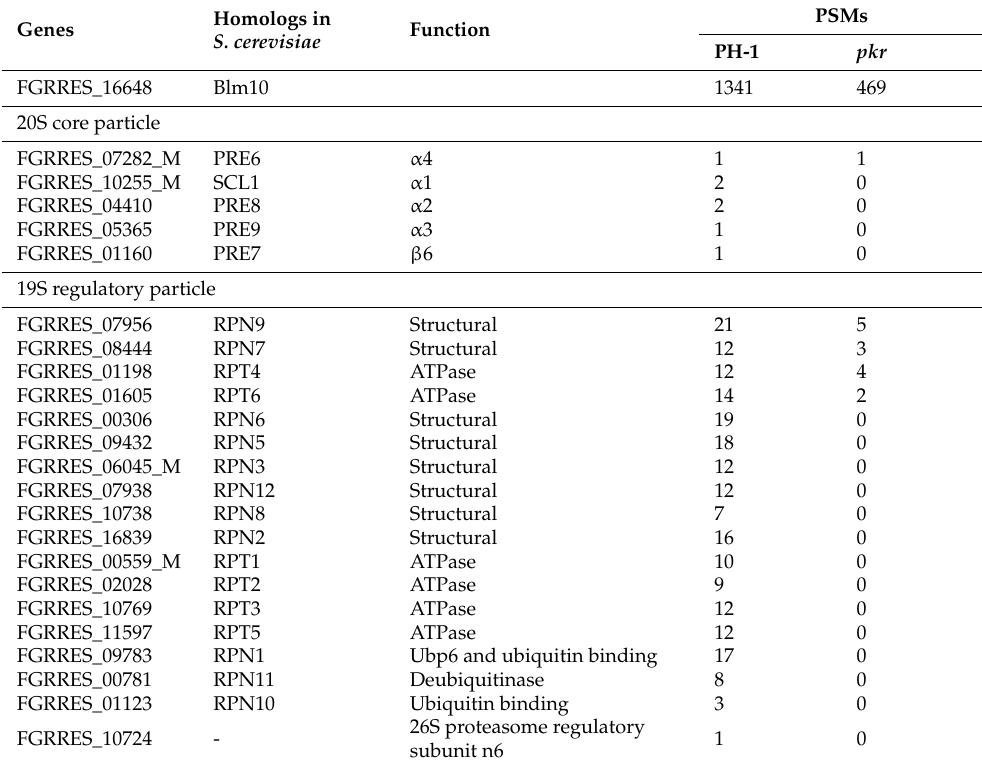
Table 4. Proteasome-associated proteins co-immunoprecipitated with FgBlm10-GFP in the wild type and pkr